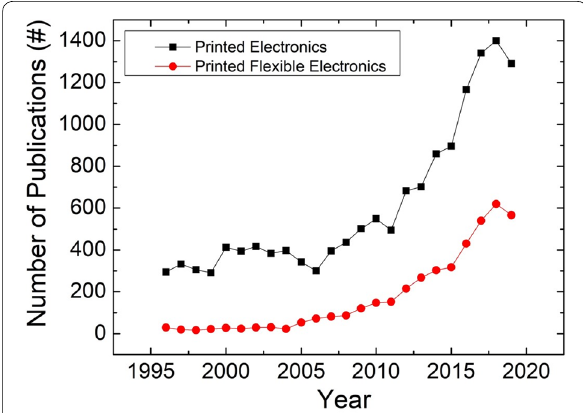
Fig. 1 Year-wise number of publications in printed electronics. The data for these plots were taken from the Web of Science by using relevant keywords (e.g., Printed Electronics). The figure also shows number of publications in printed flexible